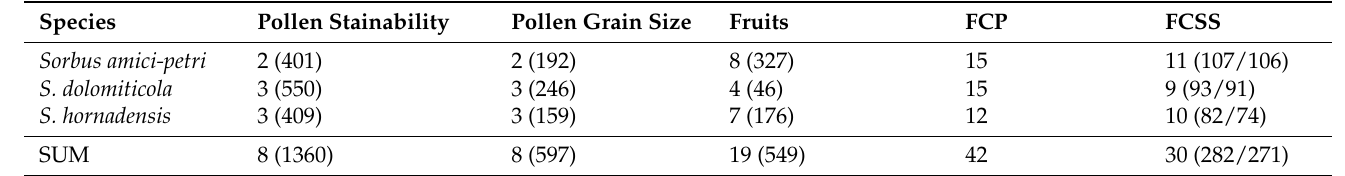
Table 2. Summary of plant material belonging to the genus Sorbus analyzed in the present study. The number of investigated individuals and number of pollen grains, fruits, and seeds used for pollen analyses ( Pollen Stainability and Pollen Grain Size ), seed production rate determination ( Fruits ), flow cytometry determination of ploidy level of mature plants ( FCP ), and flow cytometric seed screen ( FCSS ) are reported in parenthesis. For FCSS, the number of analyzed seeds and number of successfully analyzed seeds are mentioned before and after the forward slash,